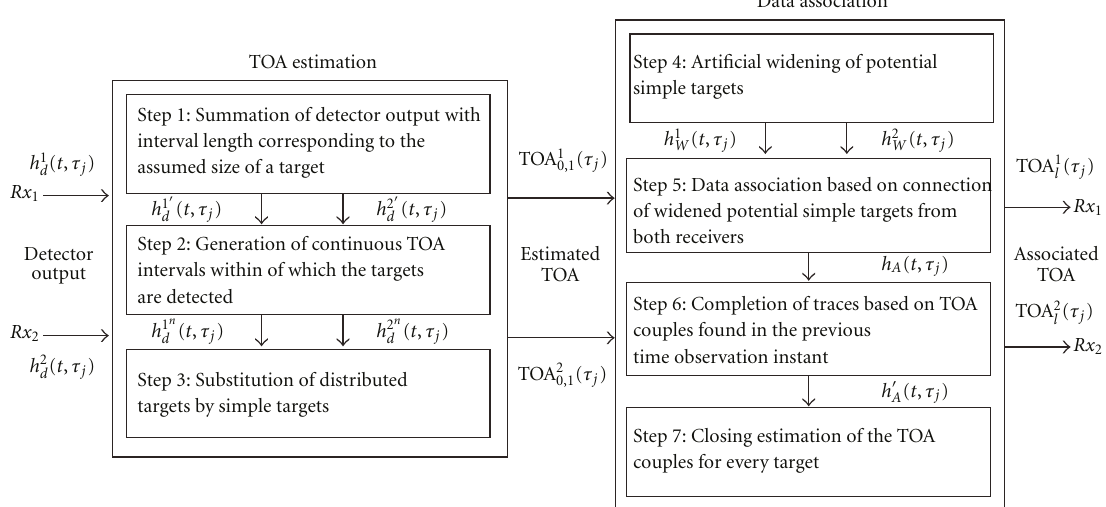
Figure 3: A simplified flowchart of the TOA association